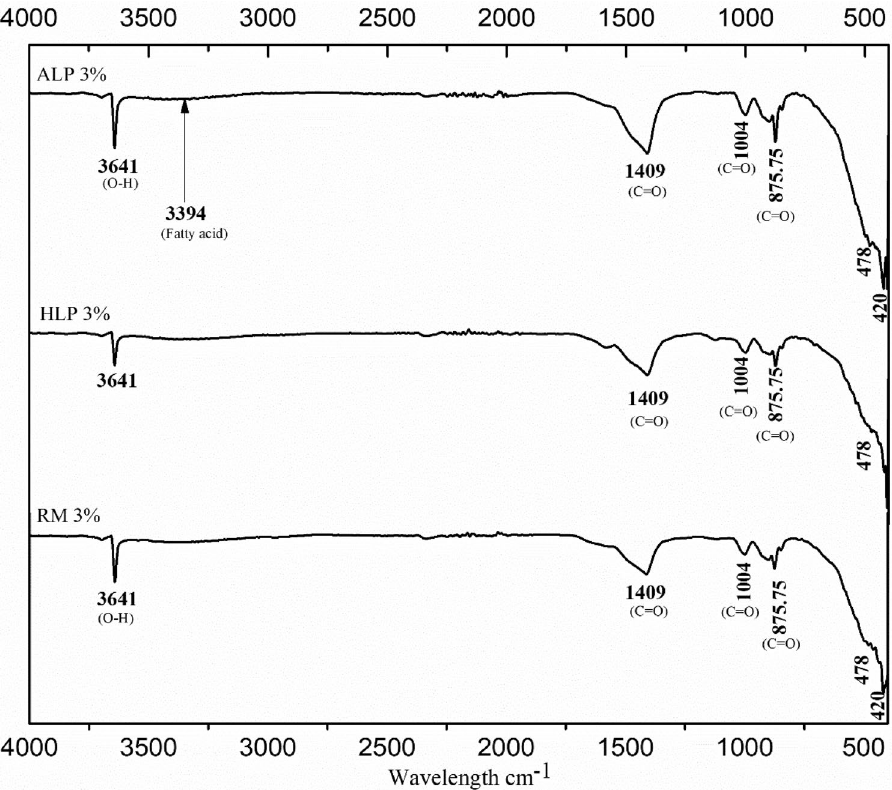
Figure 8. FT-IR spectrum of organic lime putty H.L.P.: Hibiscus lime putty, A.L.P.: Aloe vera lime putty and R.M.: Reference mortar. C = O: Calcite, O–H: